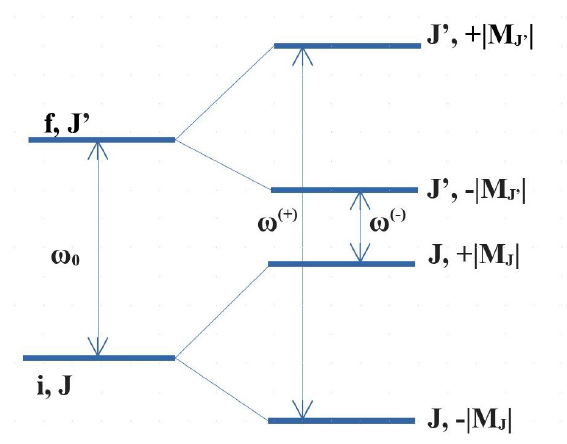
Figure 1. The scheme of the linear Stark splitting of the levels iJ and f J (cid:48)